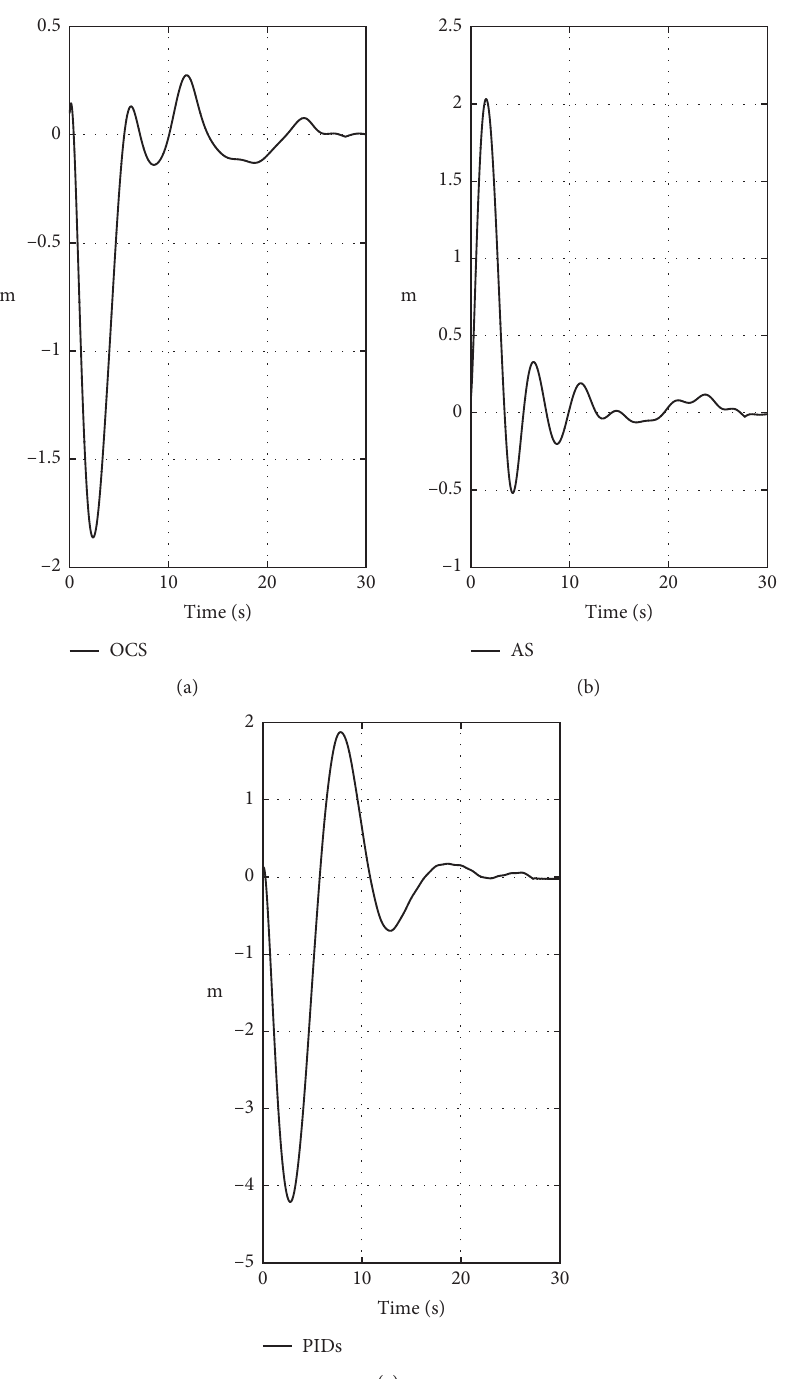
Figure 4: Comparison of the tracking trajectory position error 􏽥 h � h − h